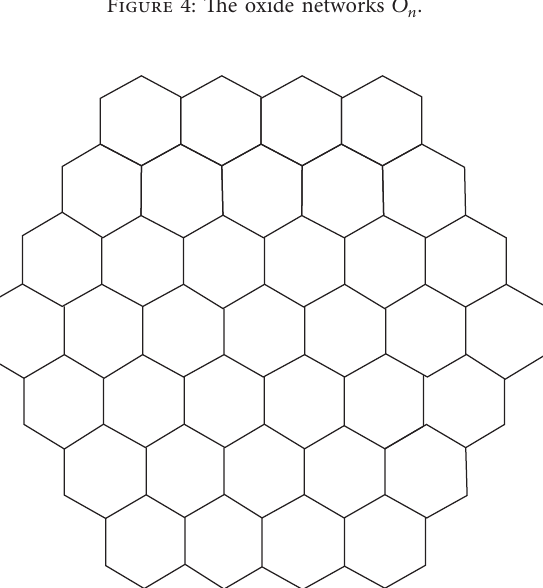
Figure 5: The cellular networks CP